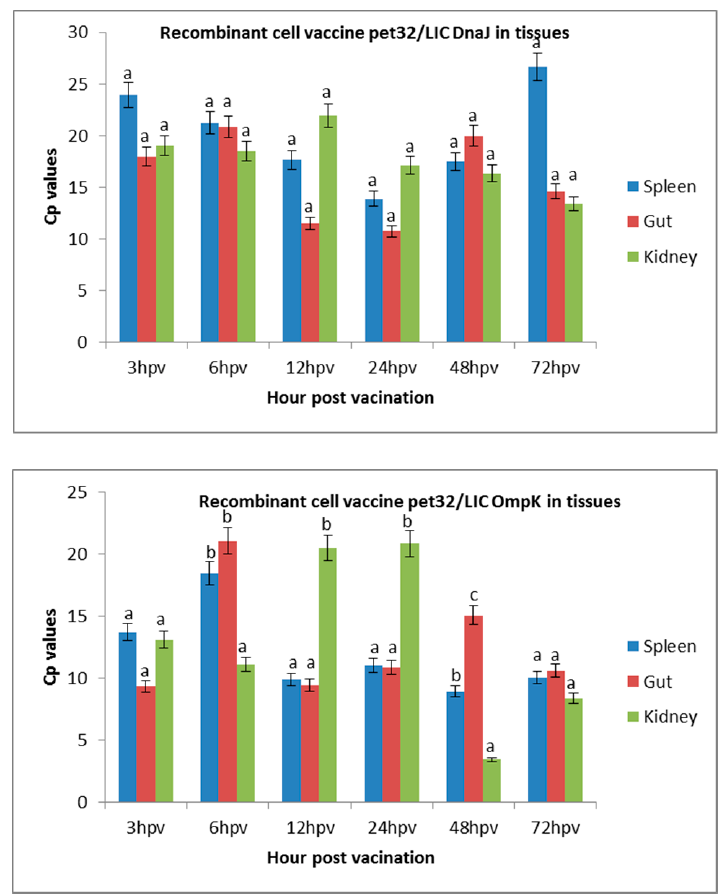
Figure 1. Expression of recombinant cell vaccines in the spleen, intestine, and kidney of vaccinated fish. The abundant expression in the spleen, gut, and kidney tissues was expressed as the crossing point (cp) value (the crossing point at which fluoresces crosses the threshold). The results are presented as means ± SD. A higher cp value indicates lower expression level. Significant differences are indicated by different letters ( p < 0.05).